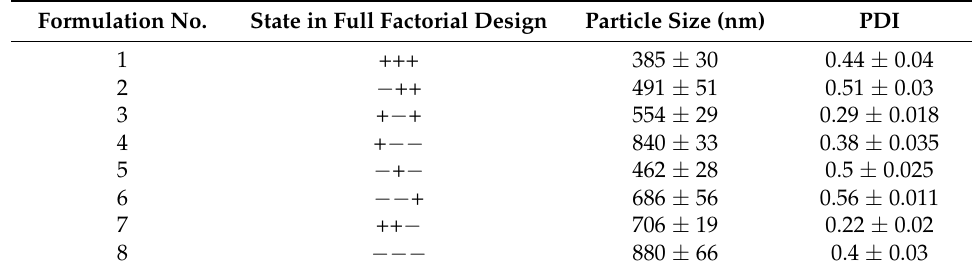
Table 2. Mean particle size and polydispersity index (PDI) for propranolol hydrochloride formulations (mean ± SD, n = 5). Formulation No.